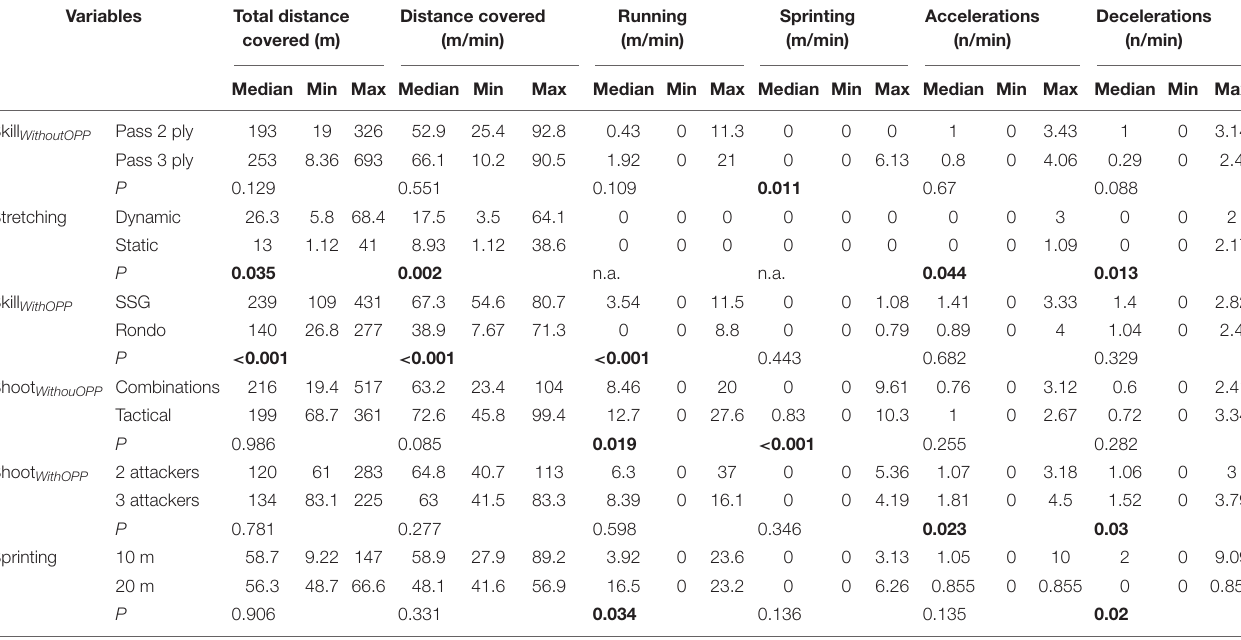
TABLE 4 | Warm-up load demands profile in each warm-up category compared with Mann–Whitney U test. Variables Total distance